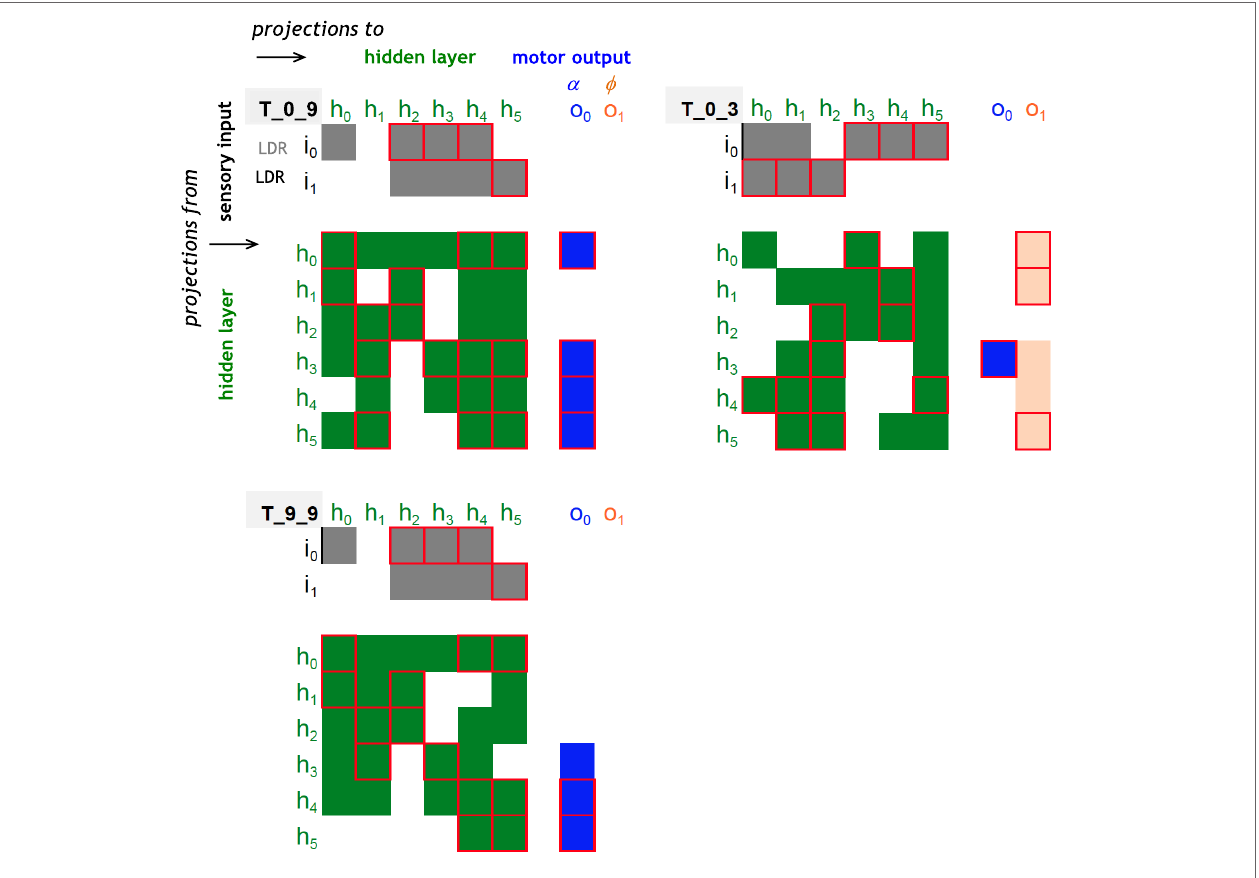
FigUre 9 | connectomes of random and evolved Tadros . Same examples used in Figures 4 and 5 . Projections from one node to another are indicated by the colored cells in the matrix, with positive (1) or negative ( − 1) connection weights with our without a red outline, respectively; lack of a connection is indicated by a blank space. Sensory projections to the hidden layer are coded in gray; hidden layer projections are coded in green when recurrent and in blue and orange for the motor output layer. T_0_9 and T_9_9 are related by descent, have an identical pattern of inputs from the sensory to the hidden layer, and have a nearly identical pattern of inputs to the motor layer, with only a difference in sign of one node and a complete lack of any nodes controlling the flapping frequency, ϕ . Contrast that pattern with the unrelated and randomly generated connectome of